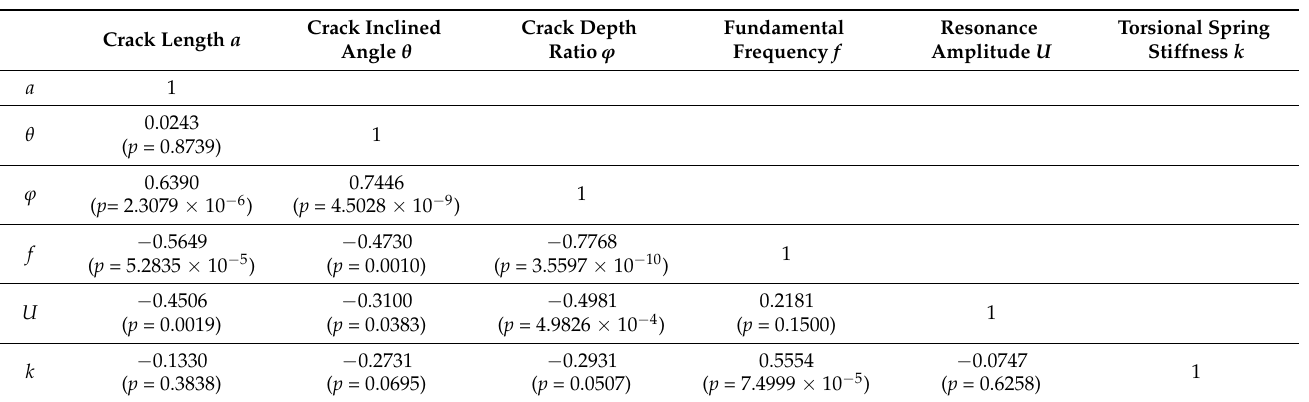
Table 2. Correlation analysis between crack dimension, dynamic response and spring stiffness (dependent variables were marked with yellow).